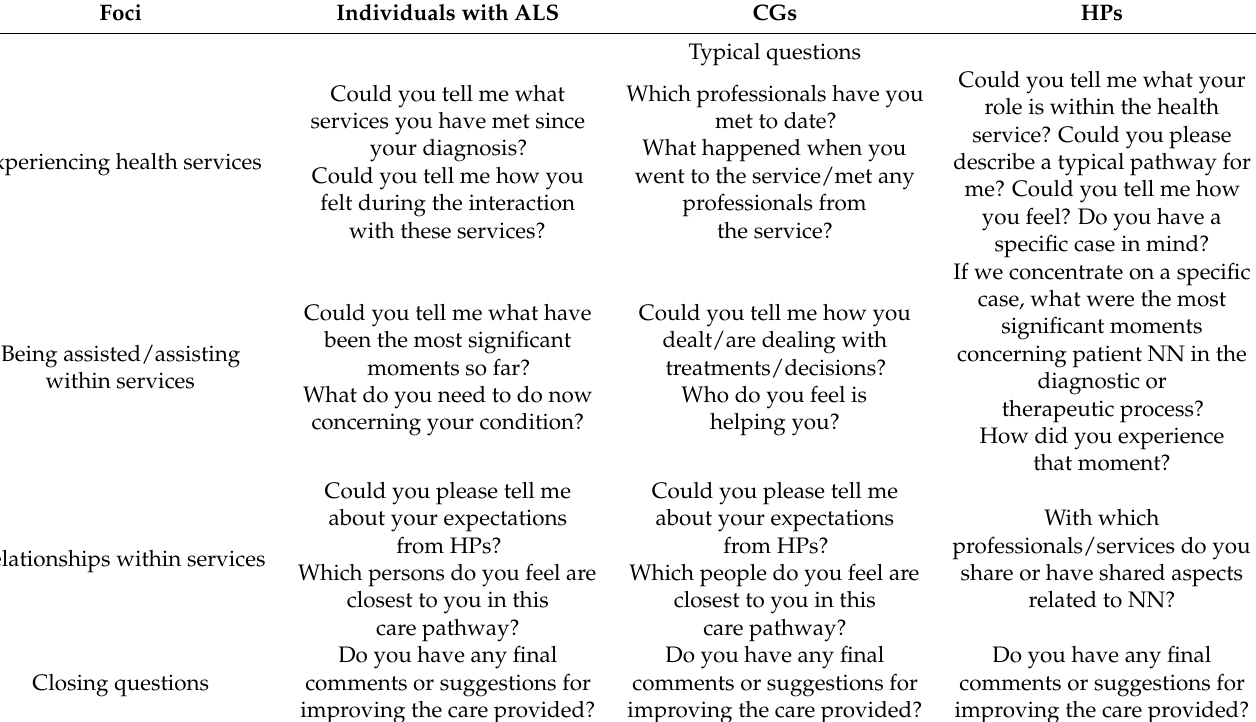
Table 1. The interview guide with examples of